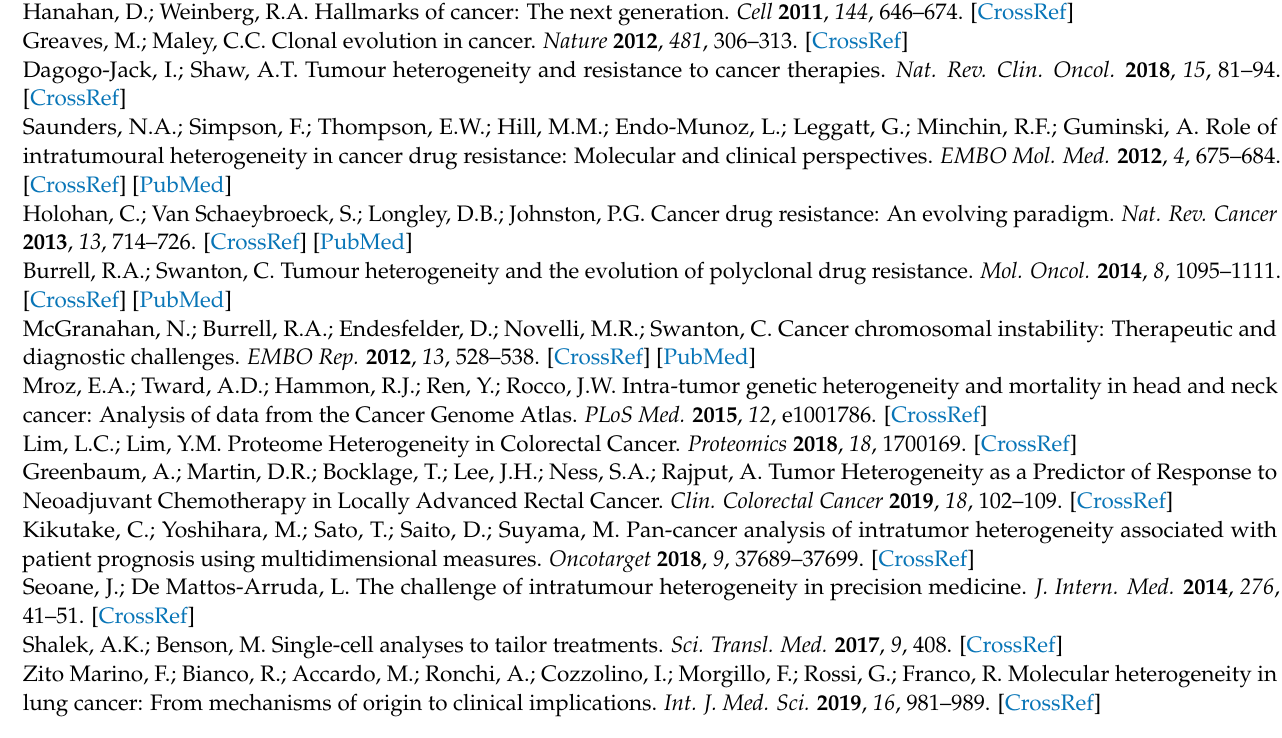
Figure S4: Schematic showing the architecture of the signal amplification, Figure S5: Mixing and washing efficiency, Figure S6: Heat map showing average protein concentration, Figure S7: Mean protein concentration change compared with control groups, Figure S8: Histograms showing protein secretion distribution, Figure S9. Cluster analysis